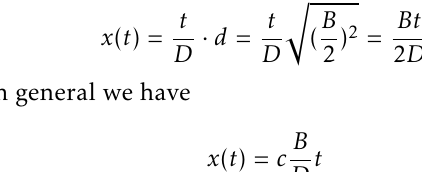
Figure 1. Illustration of game progress through a game tree At each depth of the game tree, one will choose a move and the game will progress. Calculating the length of middle line in Figure 1 is the key to get the total game progress value. To calculate it, consider Figure 2. In the game tree, we have the horizontal di ff erence between neighboring nodes (say ∆ l ), the di ff erence between levels of tree (say ∆ t ), and distance between them (say d ).